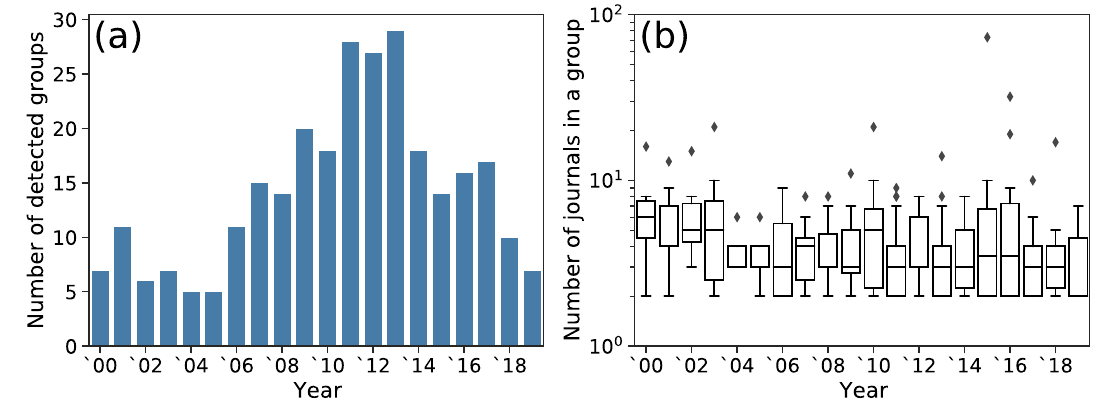
Figure 1. Statistics of anomalous citation groups detected by CIDRE. ( a ) Number of anomalous citation groups. ( b ) Number of journals in a group. A diamond indicates an outlier that does not fall in the range in [ q 0.25 − 1.5 (cid:31) IQR , q 0.75 + 1.5 (cid:31) IQR ] , where q 0.25 and q 0.75 are the first and third quartiles, respectively, and (cid:31) IQR = q 0.75 − q 0.25